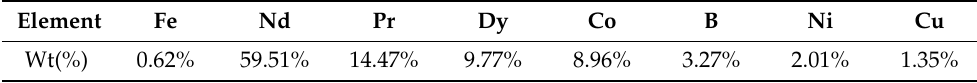
Table 3. The composition of the filtrate